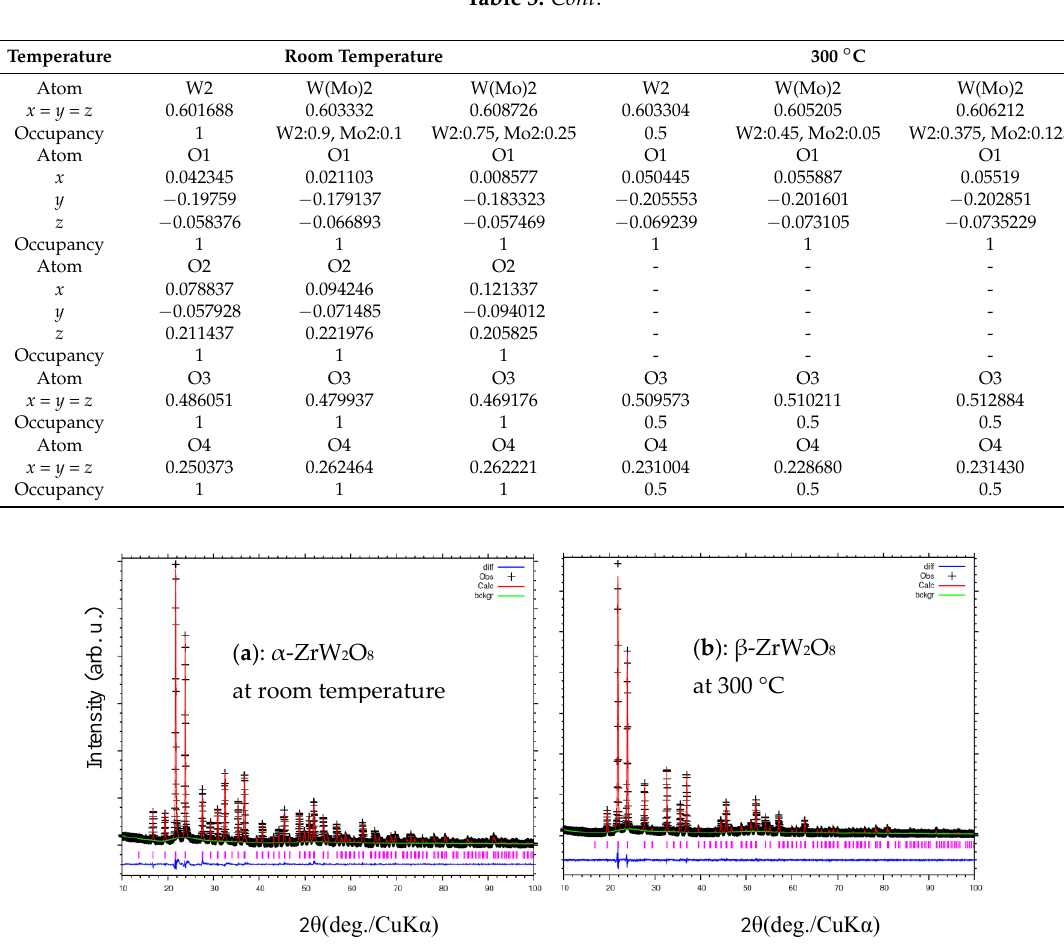
Figure 7. Rietveld refinement of X-ray diffraction patterns of ZrW 2 O 8 at ( a ) room temperature; and ( b ) 300 °C.